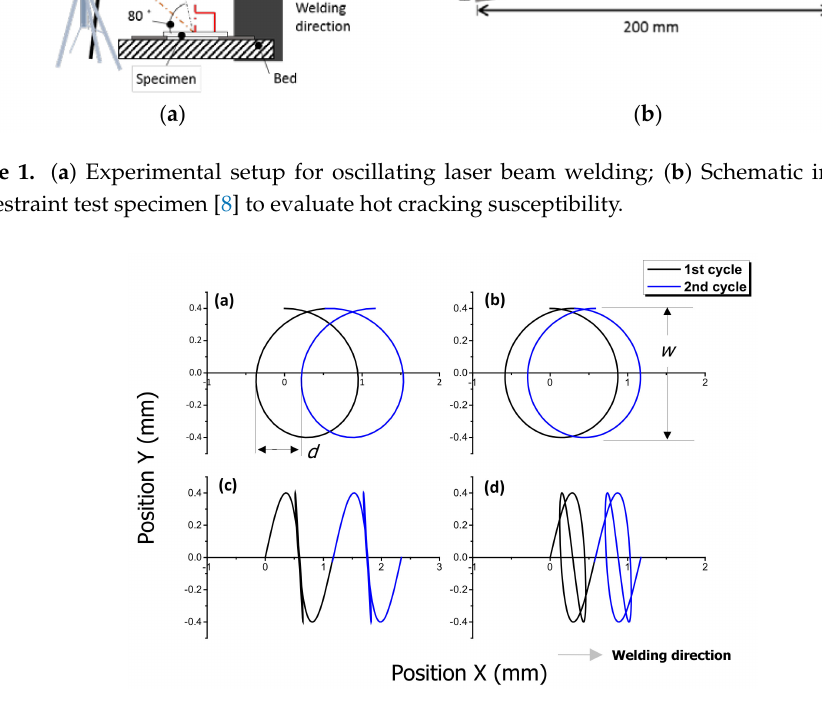
Figure 2. Circular and infinite-shaped laser oscillation beam patterns at a welding speed of 3.5 m/min, where w is the oscillation width at 0.8 mm and d is the interval between the periodic waves. ( a ) circular pattern at 100 Hz; ( b ) circular pattern at 200 Hz; ( c ) infinite-shaped pattern at 100 Hz; (d) infinite-shaped pattern at 200 Hz. Table 1. Chemical composition of base material (wt.